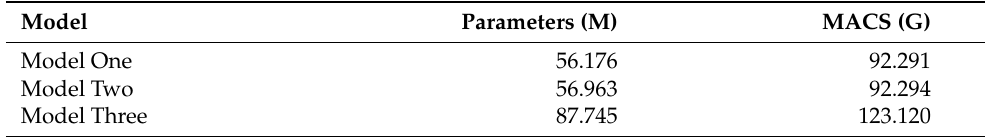
Table 5. Computational complexity of the three models in terms of parameters (in millions) and multiply-and-accumulate operations